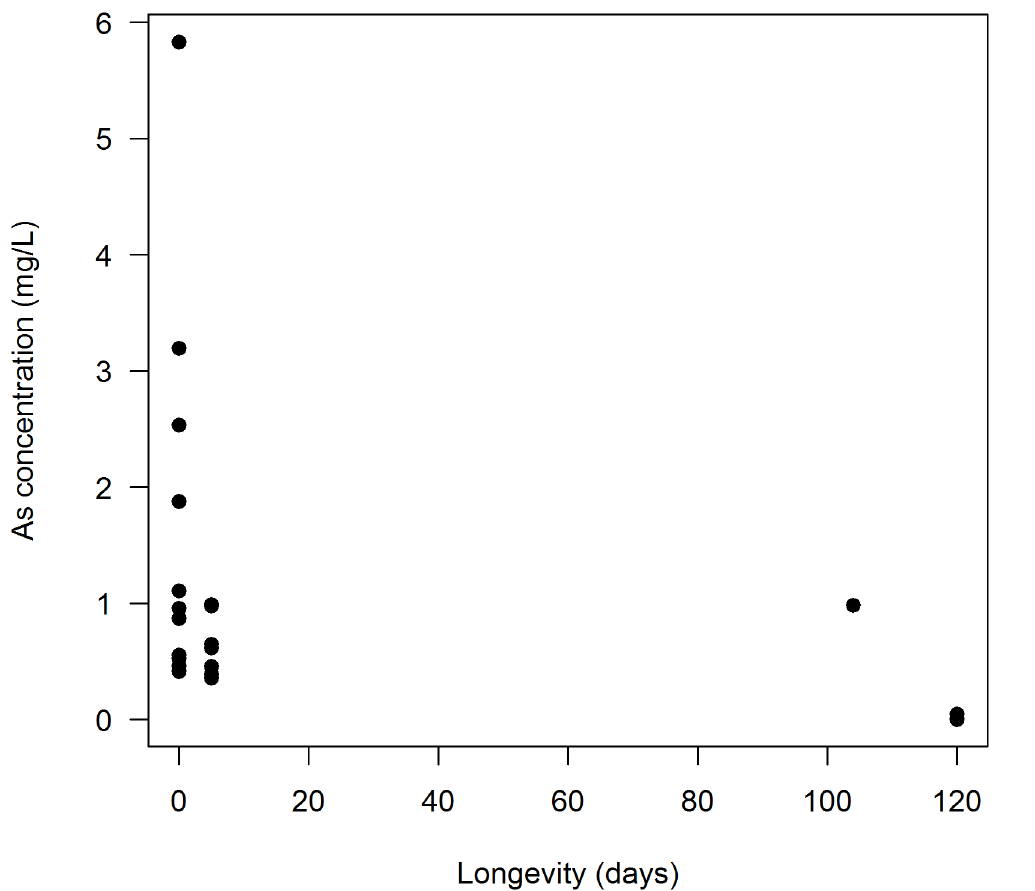
Fig 2. Concentration (mg/L) of arsenic in As-marked Triatoma brasiliensis and insect